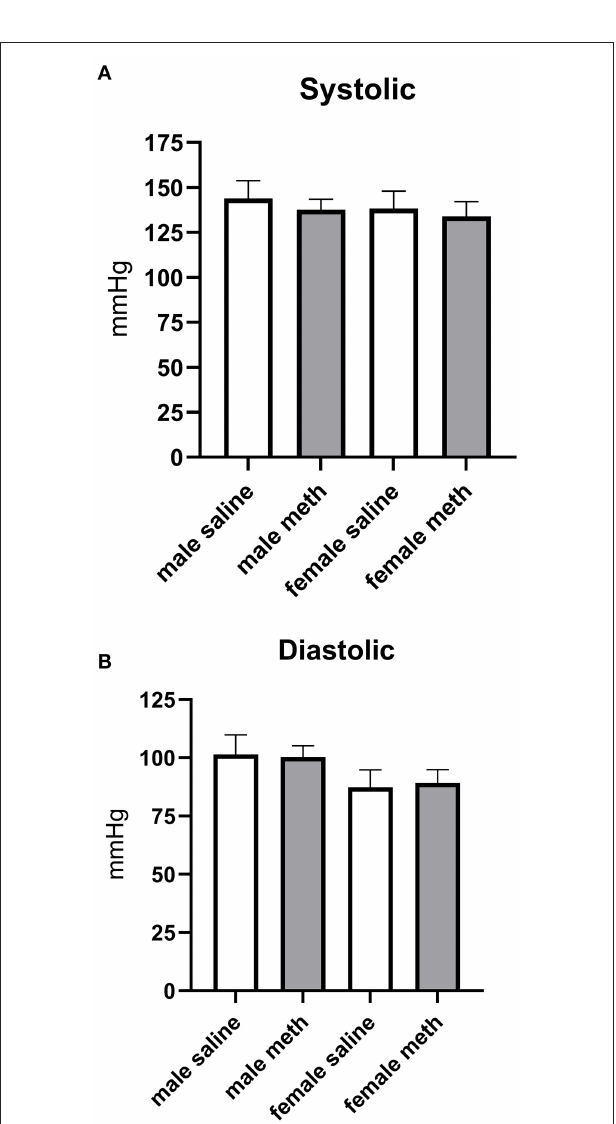
FIGURE 7 | Prenatal exposure to methamphetamine had no impact on basal systolic (A) or diastolic (B) blood pressure in male or female offspring. Data represent the mean ± SEM of 6–8 separate